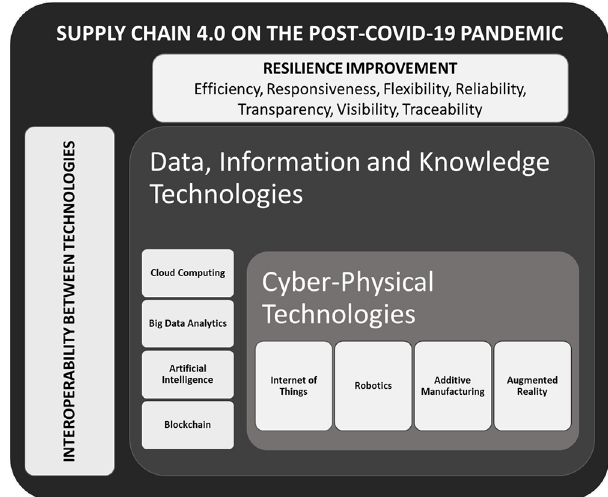
Figure 1. Supply chain